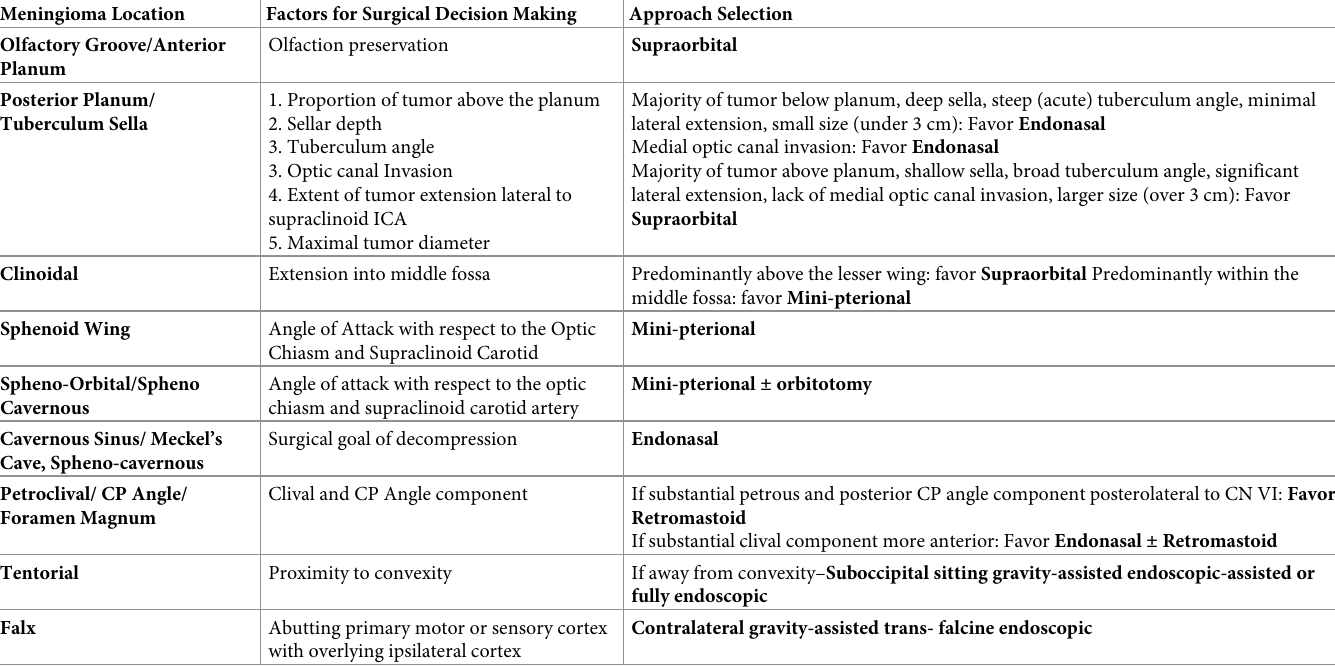
Table 1. Surgical decision making for keyhole meningioma